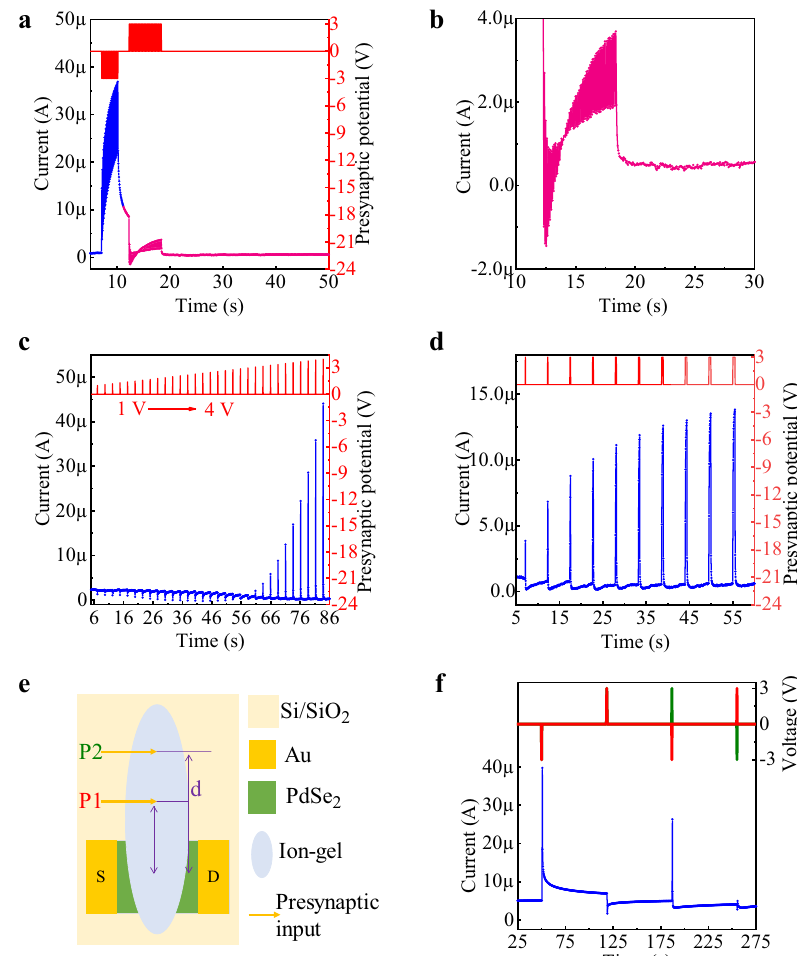
Fig. 5 Neurotransmitters interaction and short term plasticity. a Postsynaptic currents stimulated by 30 negative and 60 positive pulses. b Magni fi ed image of postsynaptic current in the dotted rectangle in ( a ). c Postsynaptic currents triggered by different amplitudes (from 1 to 4 V, with a step of 0.1 V) of presynaptic spike. d Postsynaptic currents triggered by different durations (from 51 to 510 ms, with a step of 51 ms) of presynaptic spike. e Schematic of AS with two input terminals; the perpendicular distance between the input terminal and the center of the channel is ( d ). f Integrated postsynaptic currents recorded in response to two spatially-correlated input terminals with different combinations of input